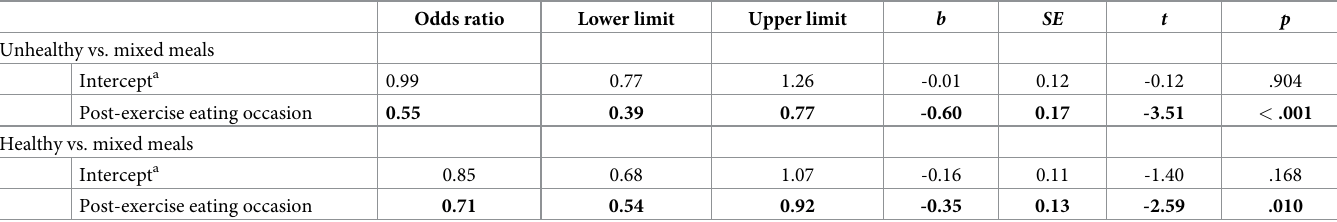
Table 4. Exercise as a predictor of meal healthiness (Study 2).